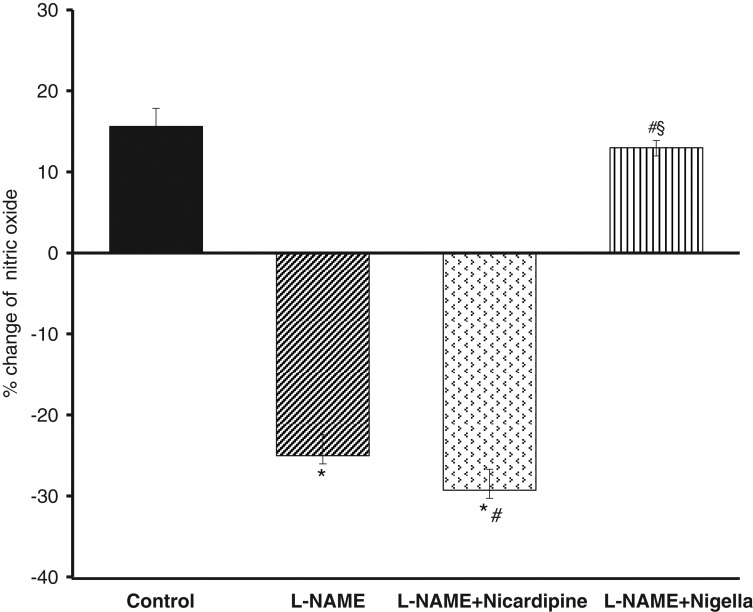
Percentage change of plasma NO (weeks 0 and 8) in rats administered L-NAME and N. sativa oil for 8 weeks. The bars represent the mean±SEM (n=6). *p<0.001 versus control, #p<0.001 versus L-NAME, §p<0.001 versus nicardipine-treated group.